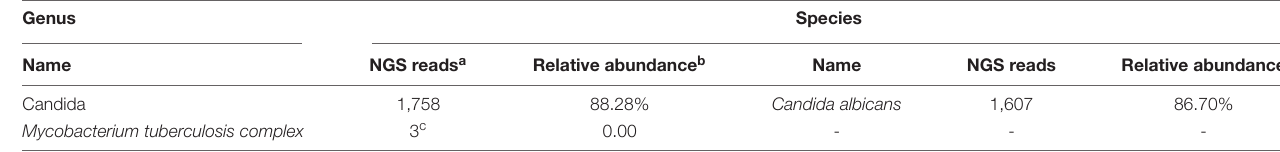
TABLE 3 | Patient’s next-generation sequencing (NGS) analysis results (https://www.ncbi.nlm.nih.gov/sra/PRJNA773989).